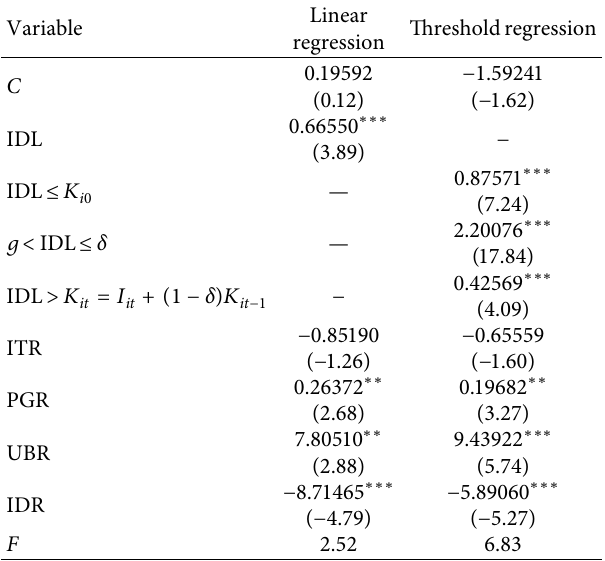
Table 10: Parameter estimation results with industrial structure as threshold